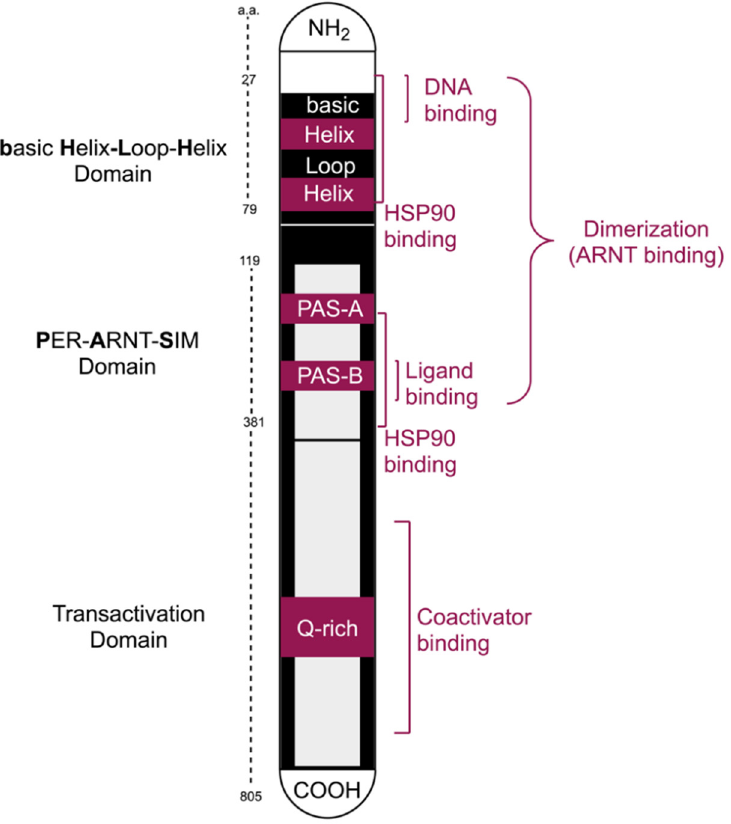
Figure 1. Schematic domain organization of the aryl hydrocarbon receptor (AhR) and its binding sites.